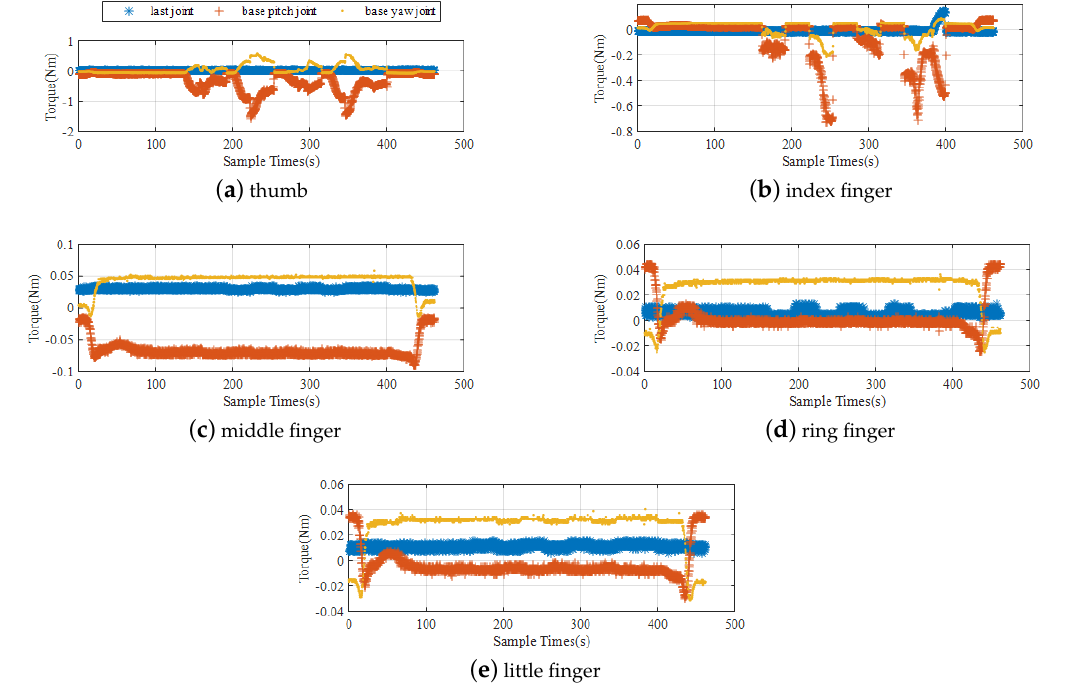
Figure 13. Torque of each finger